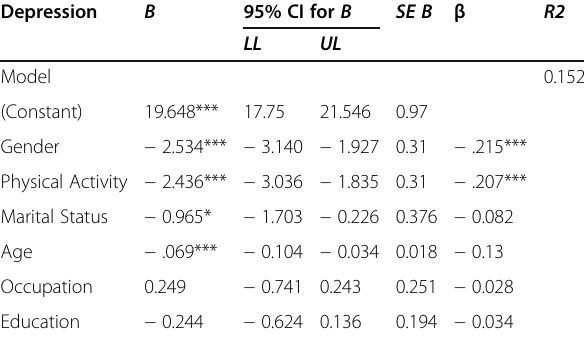
Table 5 Multiple regression results for depression